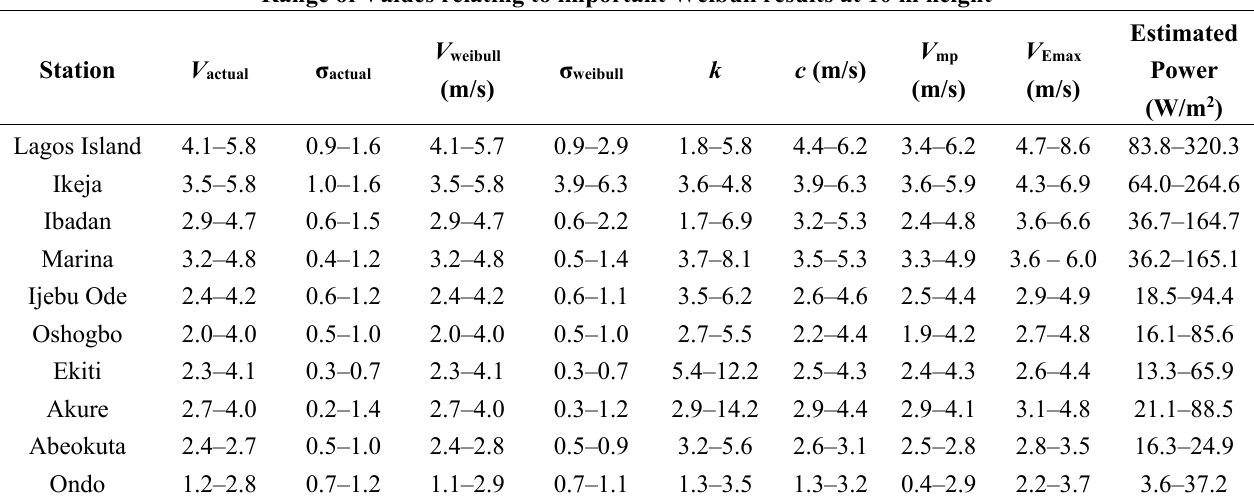
Table 2. The range of some important Weibull results for the